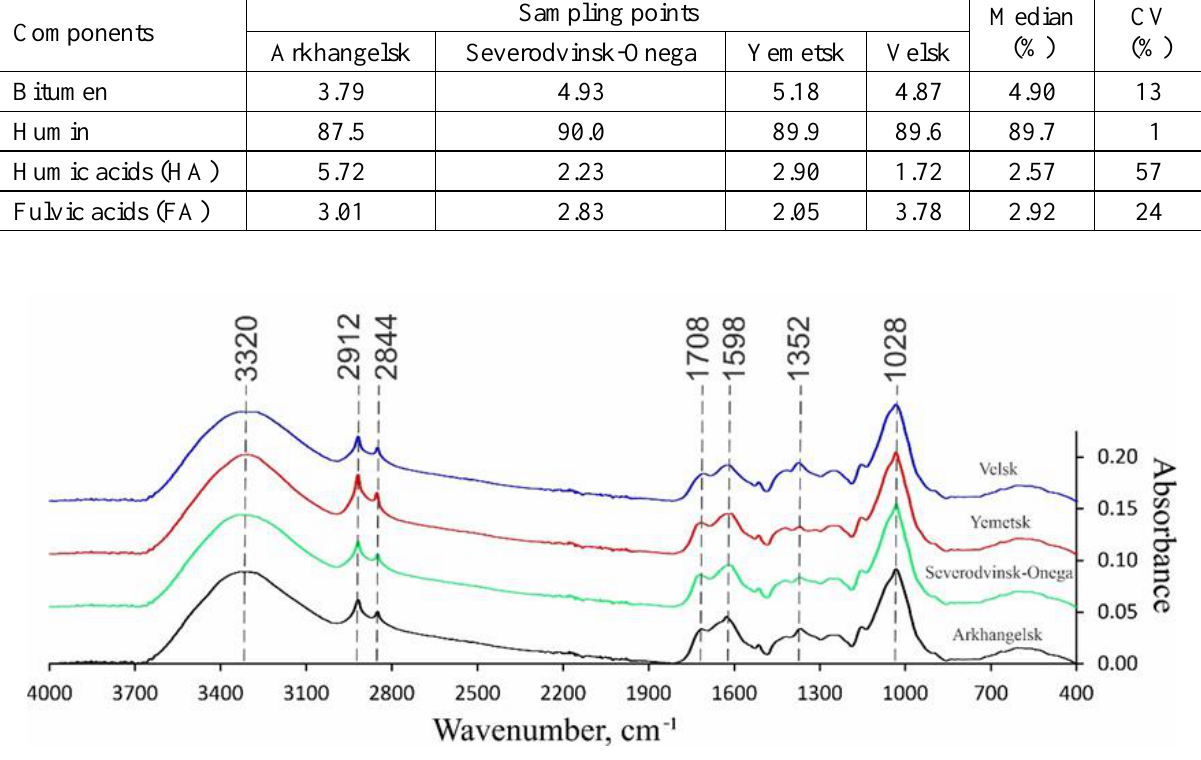
Figure 2. IR spectra of the peat